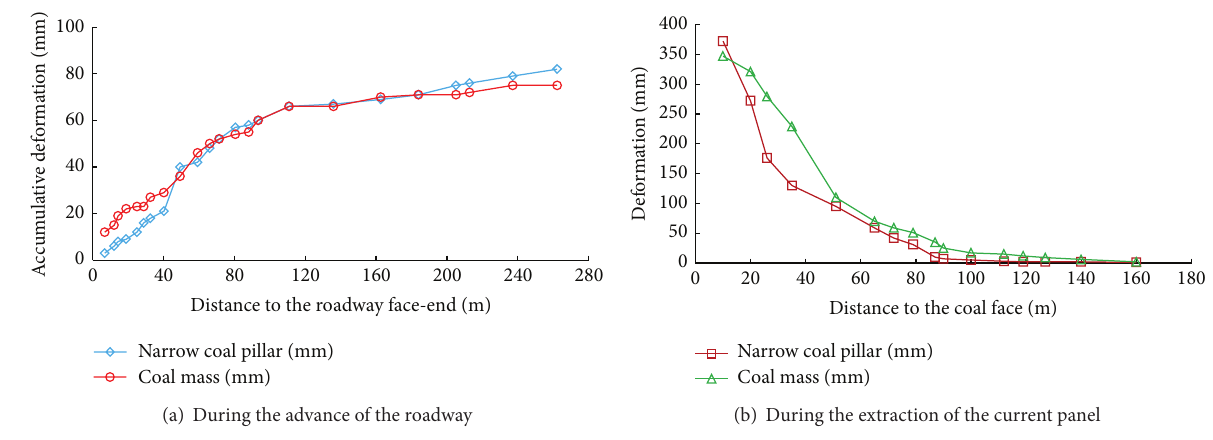
Figure 16: Monitoring results of the roadway deformation of the surrounding